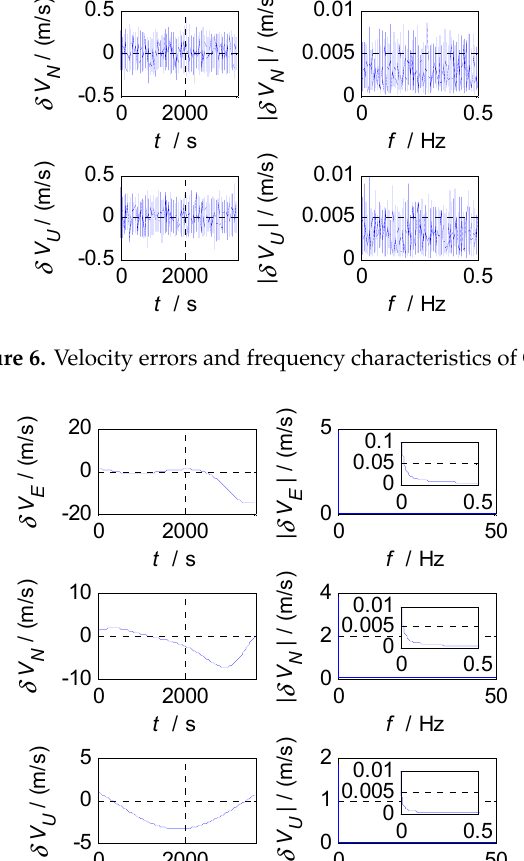
Figure 7. Velocity errors and frequency characteristics of SINS.